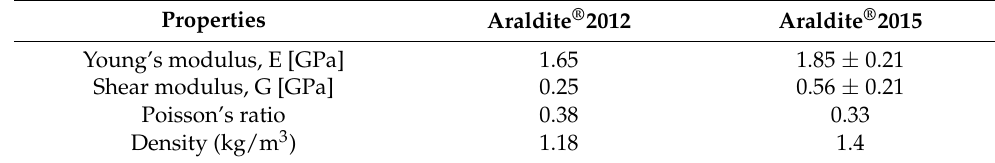
Table 2. Material properties of adhesives.